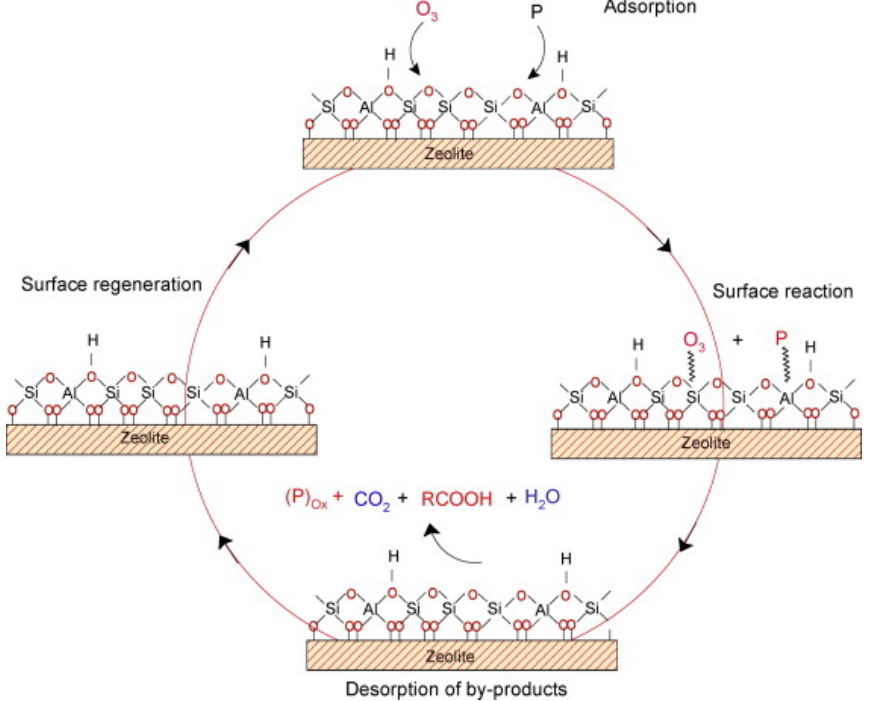
Figure 22. The schematic mechanism of catalytic ozonation on ZSM-5 zeolites (P = pollutant). Reproduced from Ref. [137]. Copyright 2014 Elsevier.